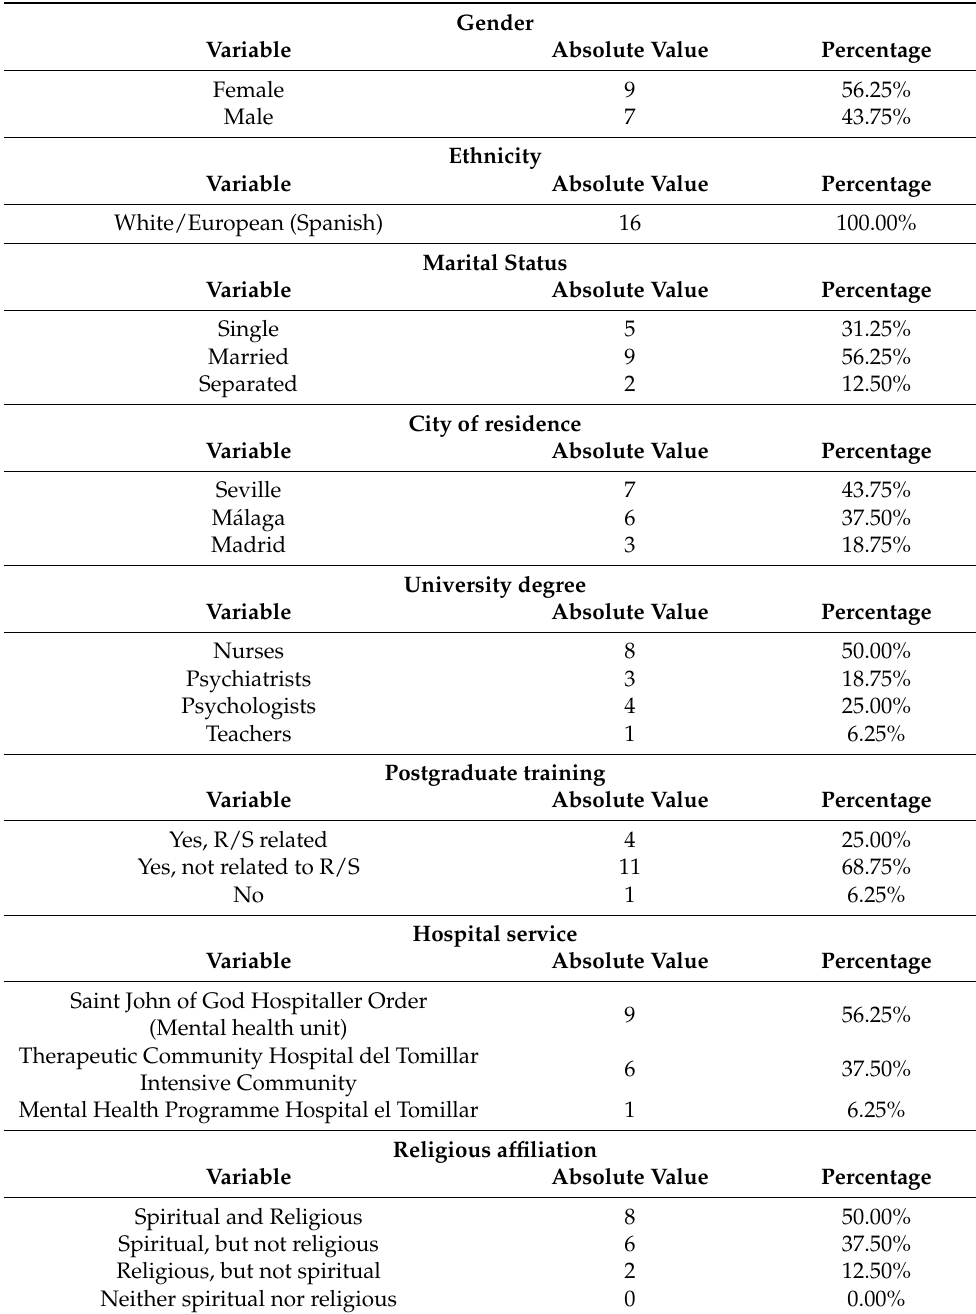
Table 1. Socio-demographic characteristics of the